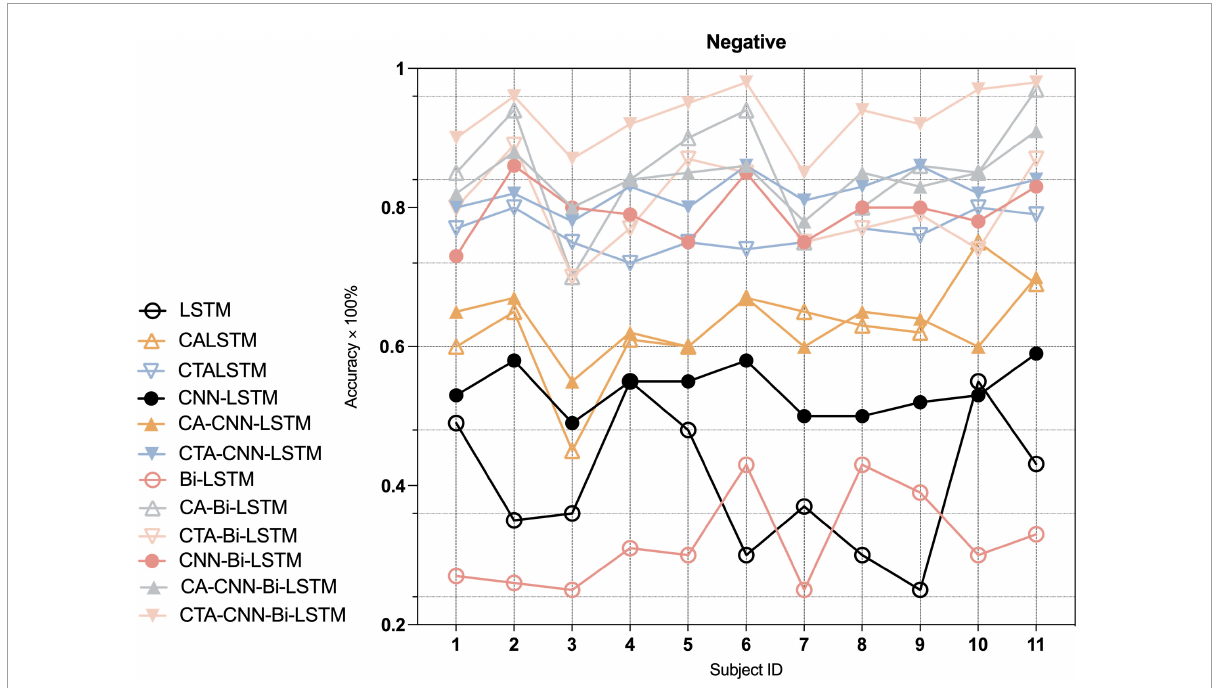
FIGURE7 Average accuracy (%) of baseline and proposed method on the recognition of negative emotion in each individual.